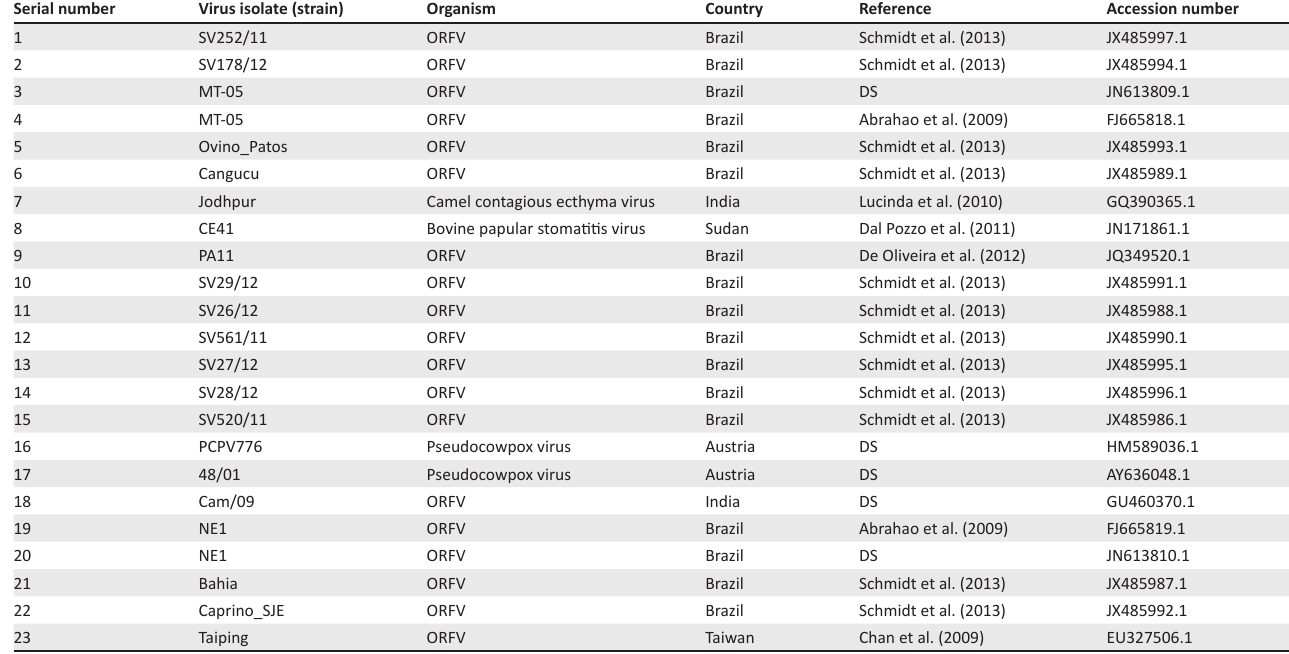
TABLE 1: Nucleotide sequences of ORF011 gene that were aligned in the samples of the present study. Serial number